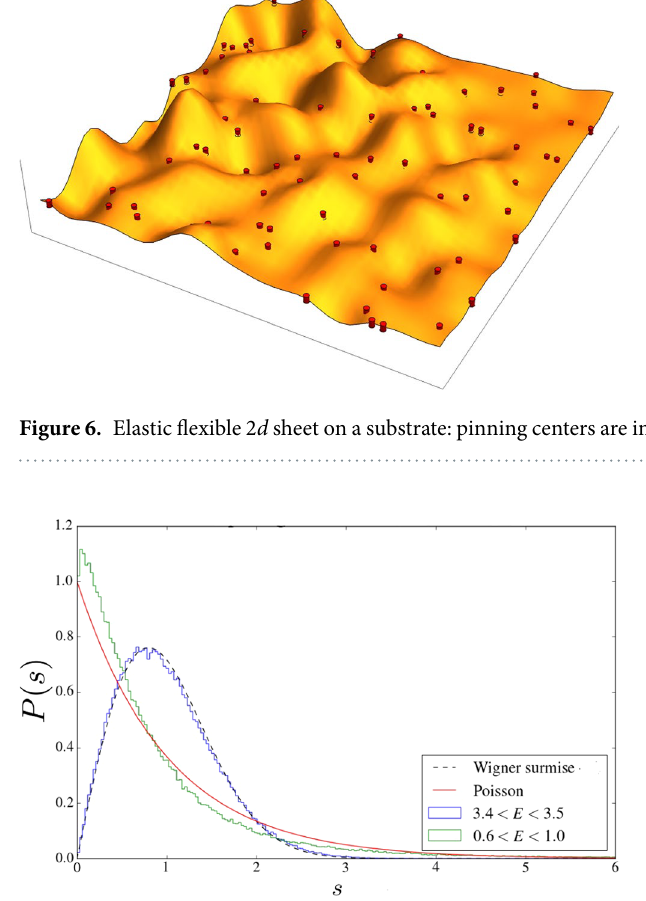
Figure 7. Crossover from the Poisson to Wigner-Dyson level statistics at 20%